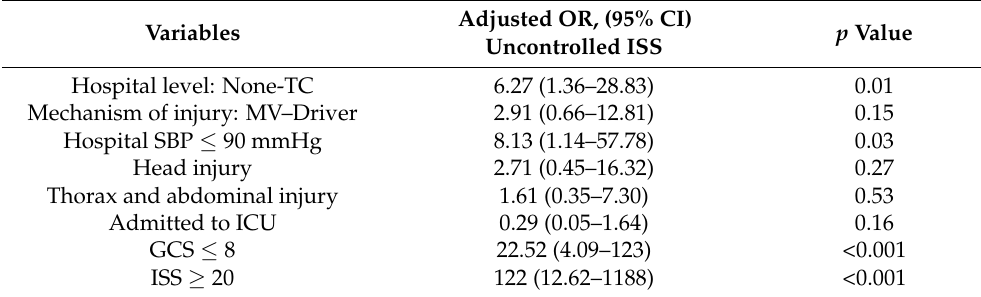
Table 6. Logistic regression predicting likelihood of mortality following